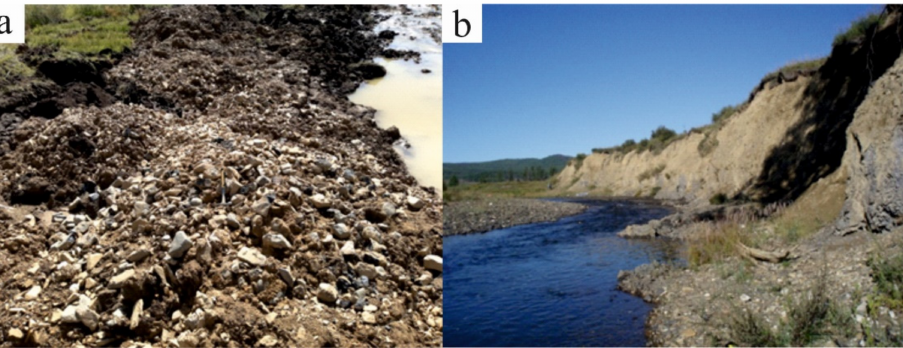
Figure 10. “Valley” volcanic rocks: ( a ) alluvial and deluvial deposits of the Naryn-Gol Creek and ( b ) rocks exposed in the Darkhintuy River